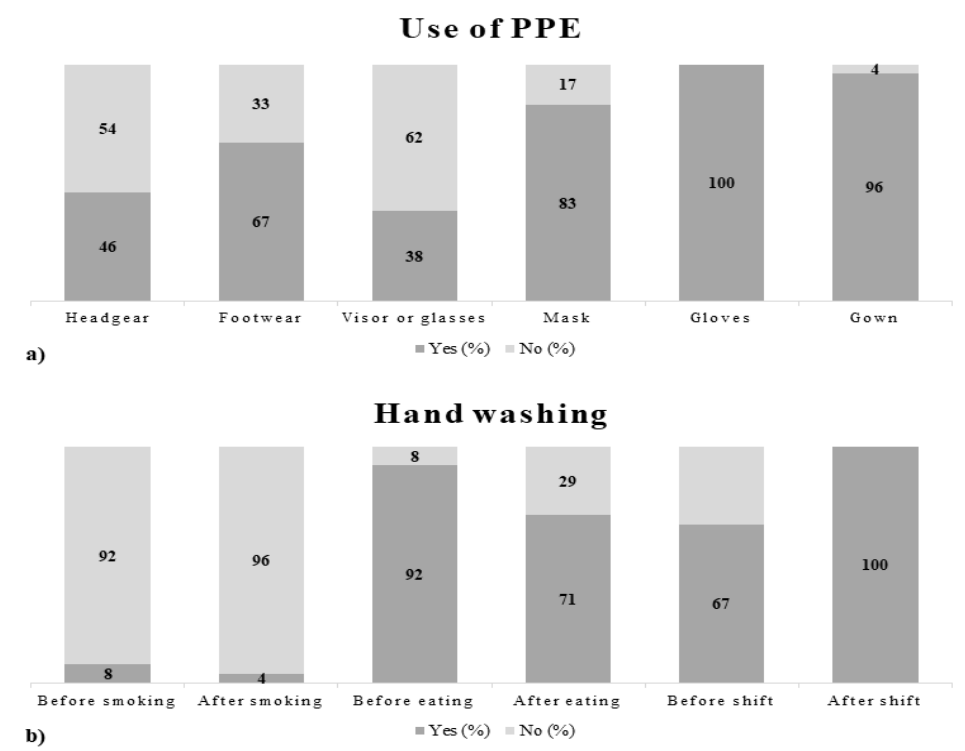
Figure 2. ( a ) Data on use of personal protective equipment (PPE); ( b ) data on hand washing performance.